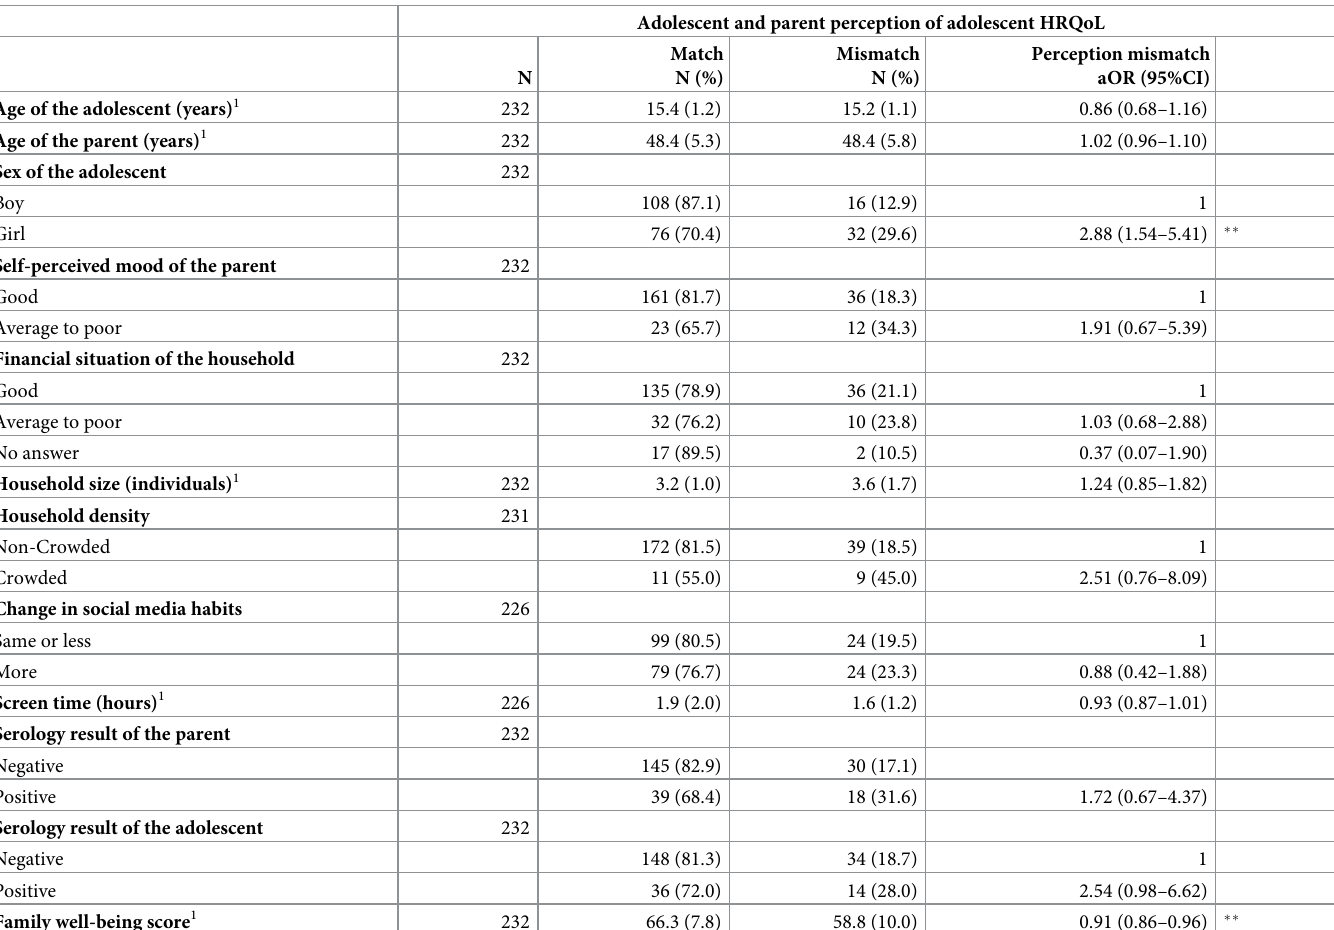
Table 4. Risk factors of discrepancies between adolescents’ and parents’ perception of adolescents’ low